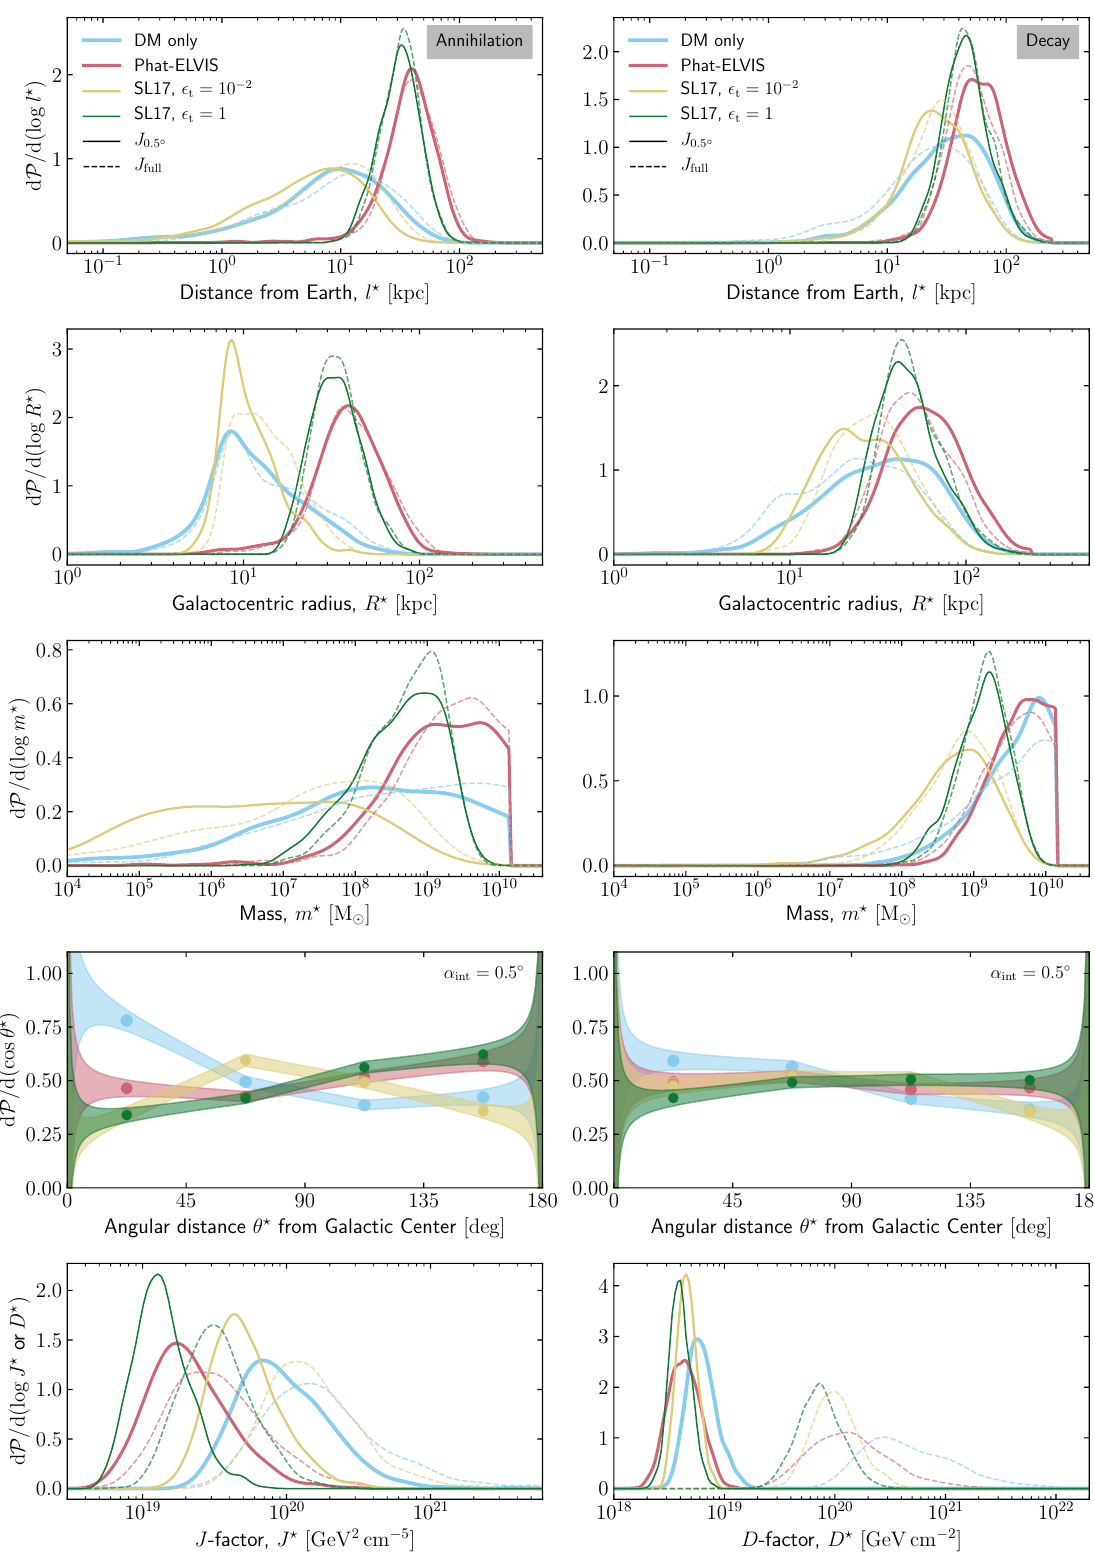
Figure 5. PDFs of the γ -ray (or ν ) brightest galactic subhalo properties for the four investigated models. ( Left panel ): annihilating DM. ( Right panel ): decaying DM. Solid lines show the statistics for only the emission from the innermost α int = 0.5 ◦ of a subhalo, dashed lines the emission over the full